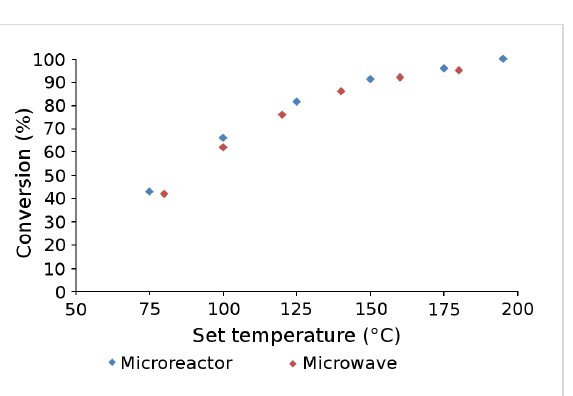
no degradation of the diaryl ether 7 was observed